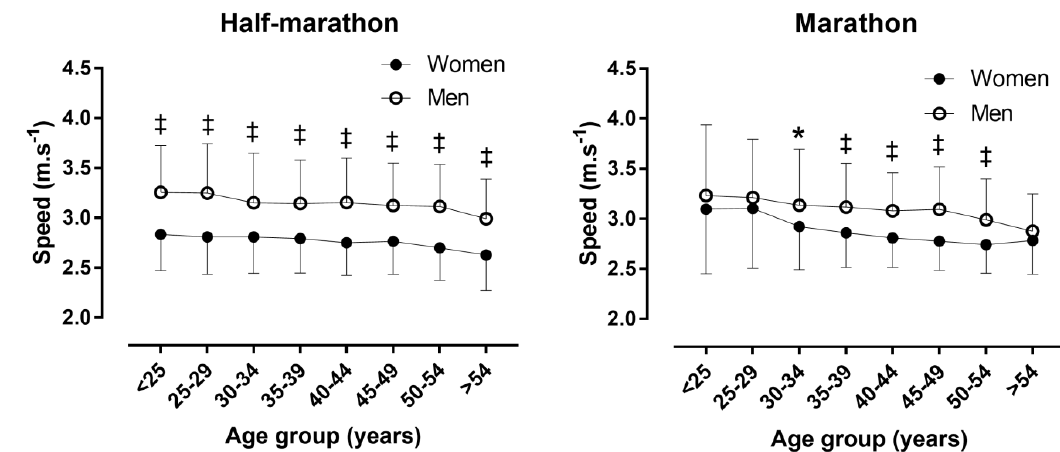
Figure 1. Race speed by race distance, gender, and age group. Error bars represent standard deviations, * p < 0.05; ‡ p < 0.001.